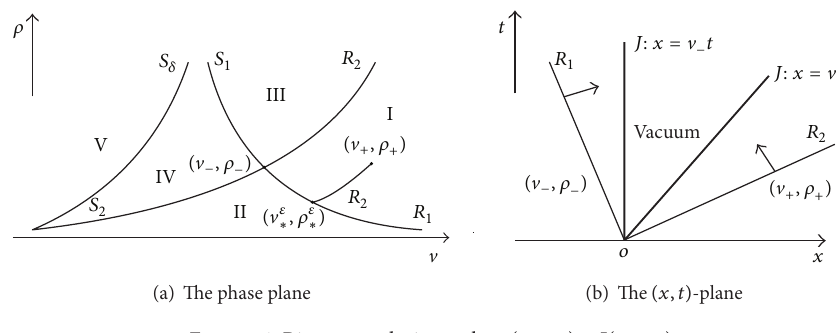
Figure 4: Riemann solutions when ( V + , 𝜌 + ) ∈ I ( V − ,𝜌 − )